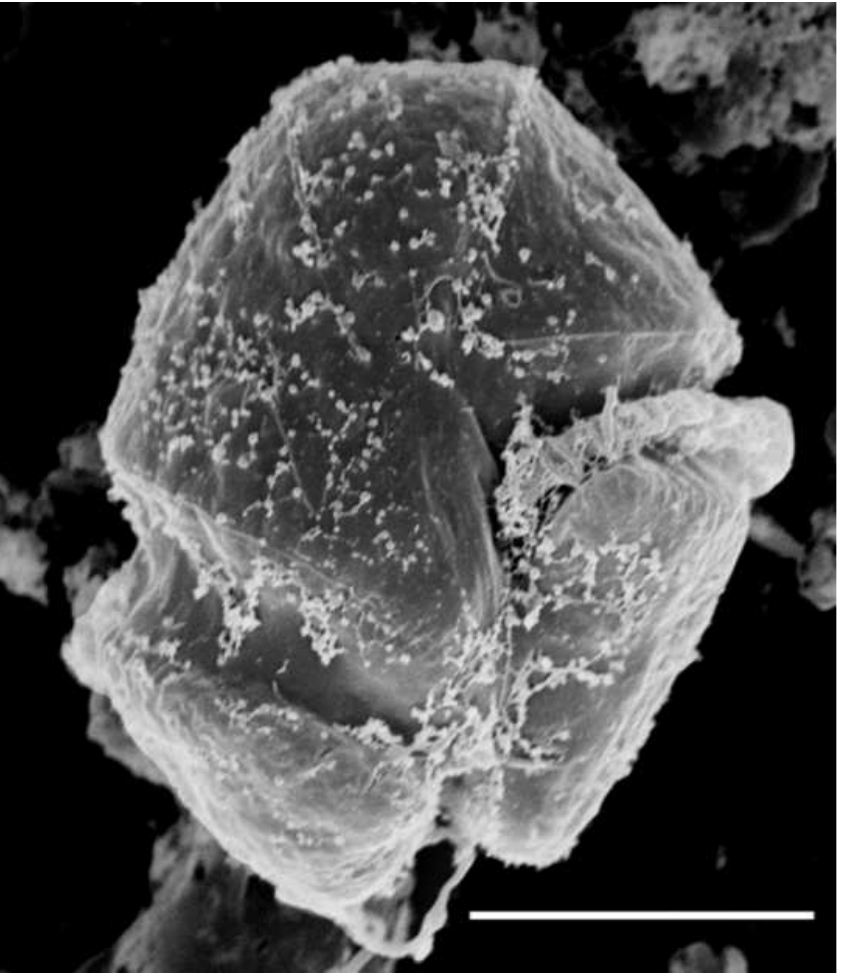
Figure 3. Scanning electron micrograph of a Gymnodinium instriatum vegetative cell, collected at the study site on 18 May 2006, during a bloom of this dinoflagellate. Scale bar = 10